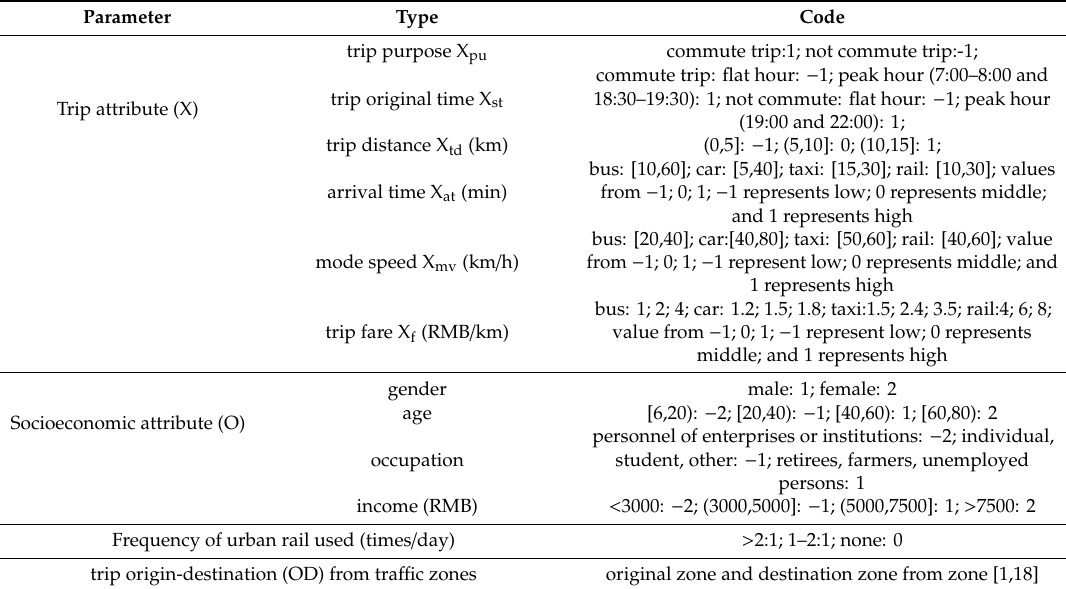
Table 1. Attribute level and